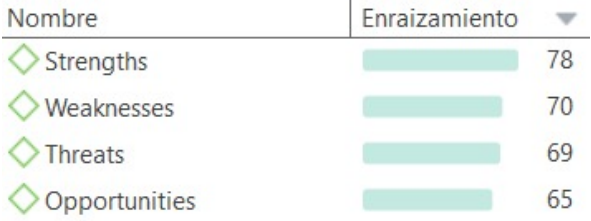
Figure 1. Rooting of the codes referred to the SWOT analysis 1 .